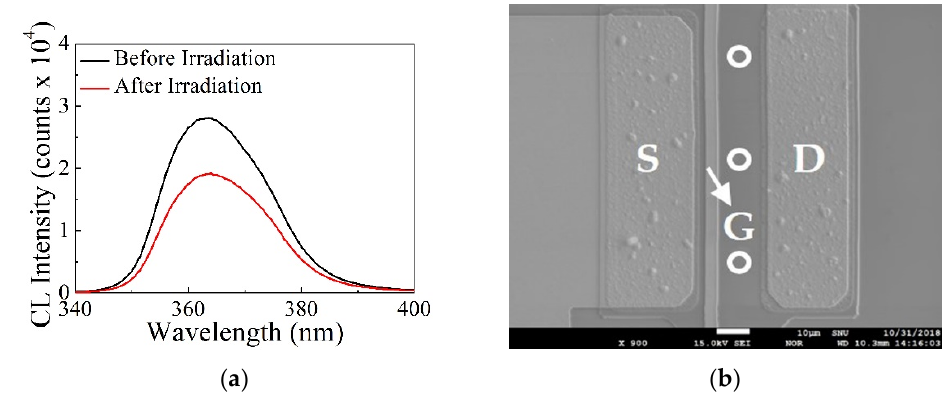
Figure 6. ( a ) Cathodoluminescence (CL) spectra of normally-off AlGaN/GaN gate-recessed MISHFETs before and after proton irradiation. ( b ) SEM image of the analyzed device.